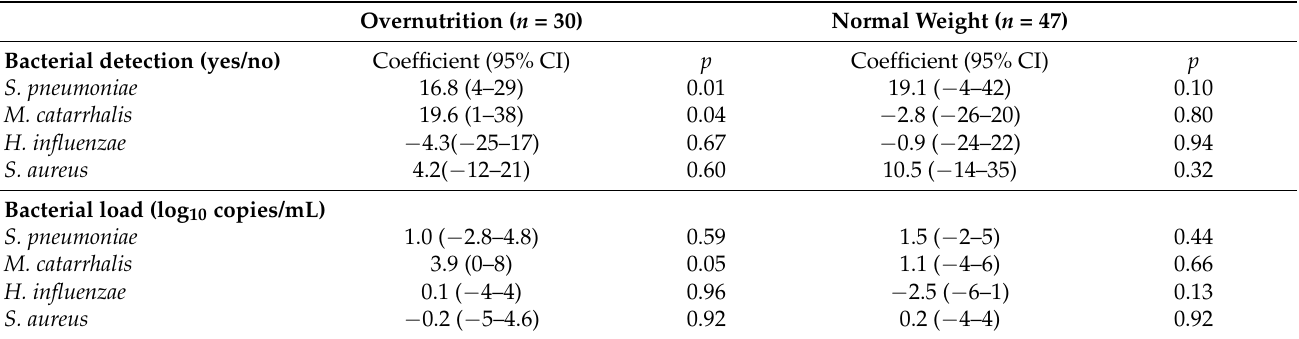
Table 2. Relationship between Nasopharyngeal Bacterial Detection and Bacterial Loads with Plasma IL-6 According to Nutritional